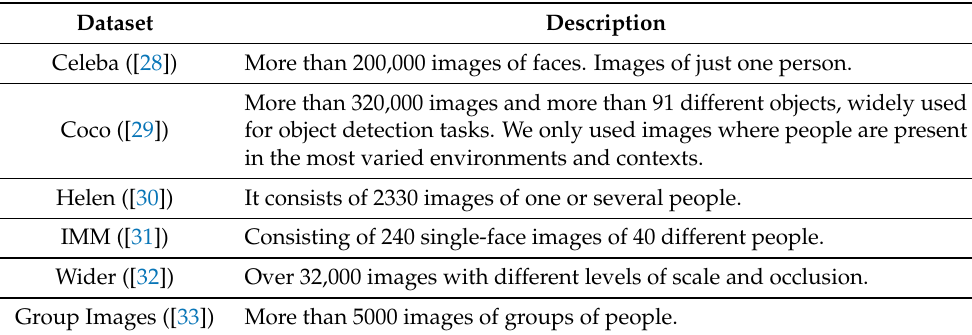
Table 1. Datasets where proposed tool was